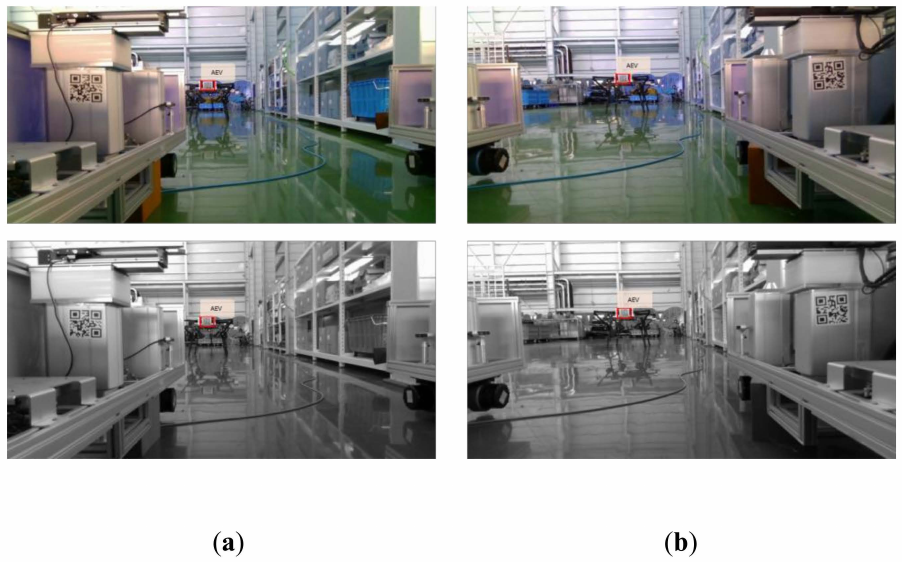
Figure 13. AEV’s marker recognized at a distance of 7 m from the mobile station. ( a ) Left Camera Image, ( b ) Right Camera Image.